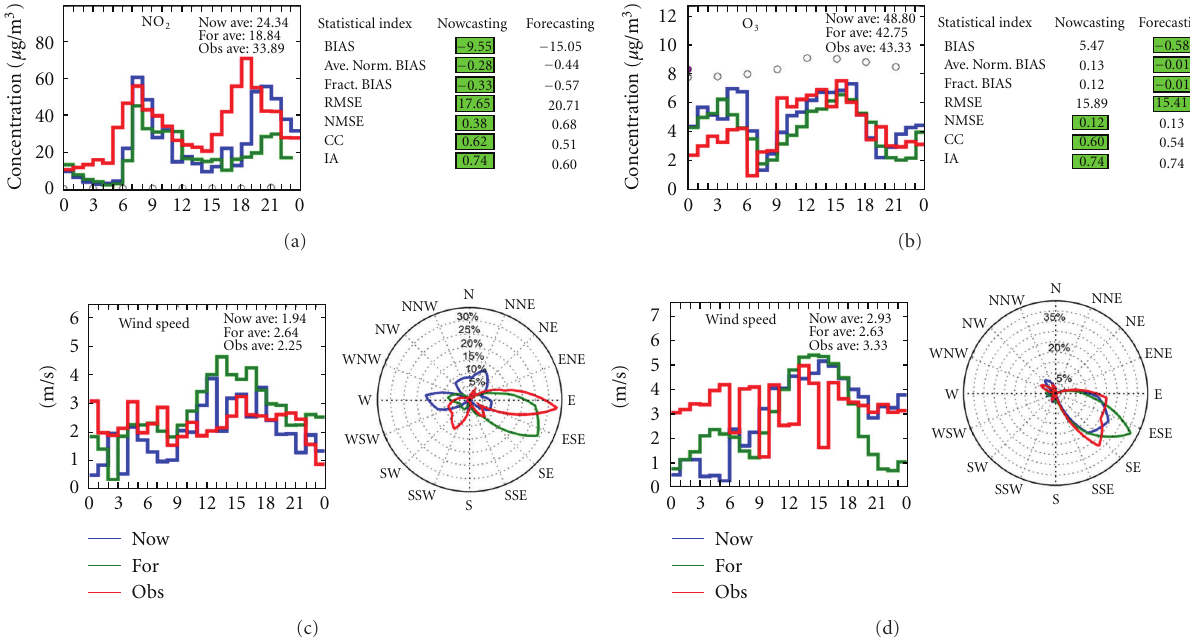
Figure 7: Air quality and meteorological validation graphs as regards the residential station of Nicosia for the 4th and 10th of March 2010 concerning NO 2 and O 3 , respectively.